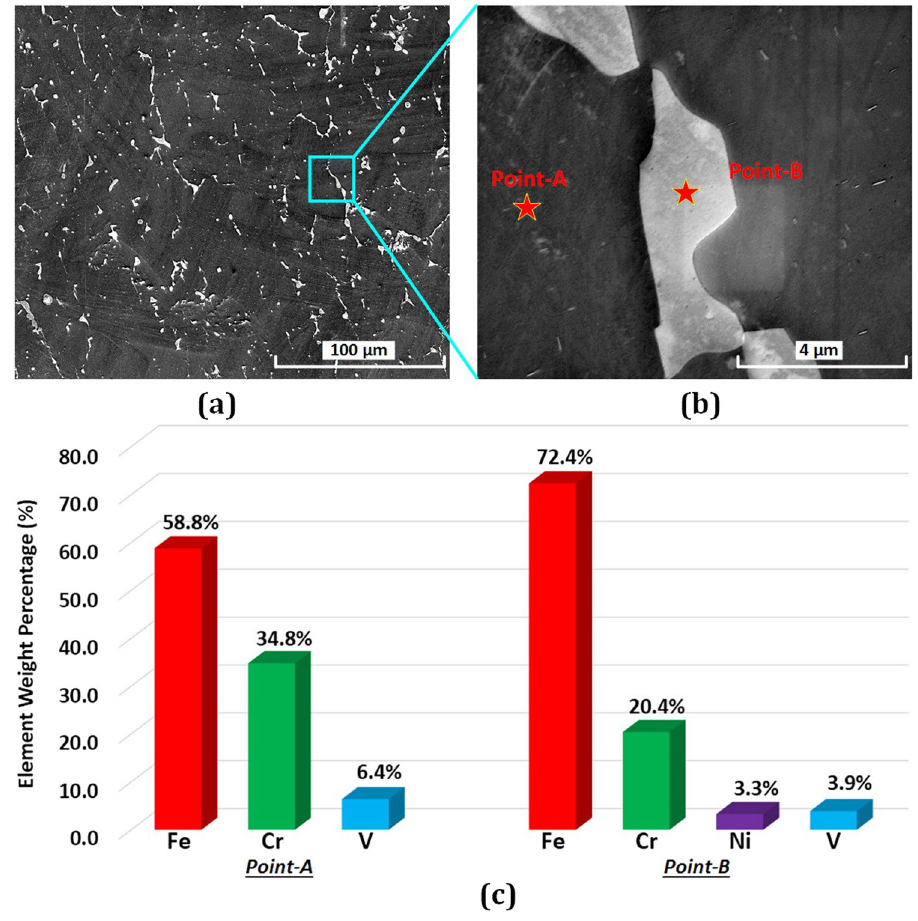
Figure 12. Micrographs at Cr/Fe interface ( a ) and ( b ), and element compositions ( c